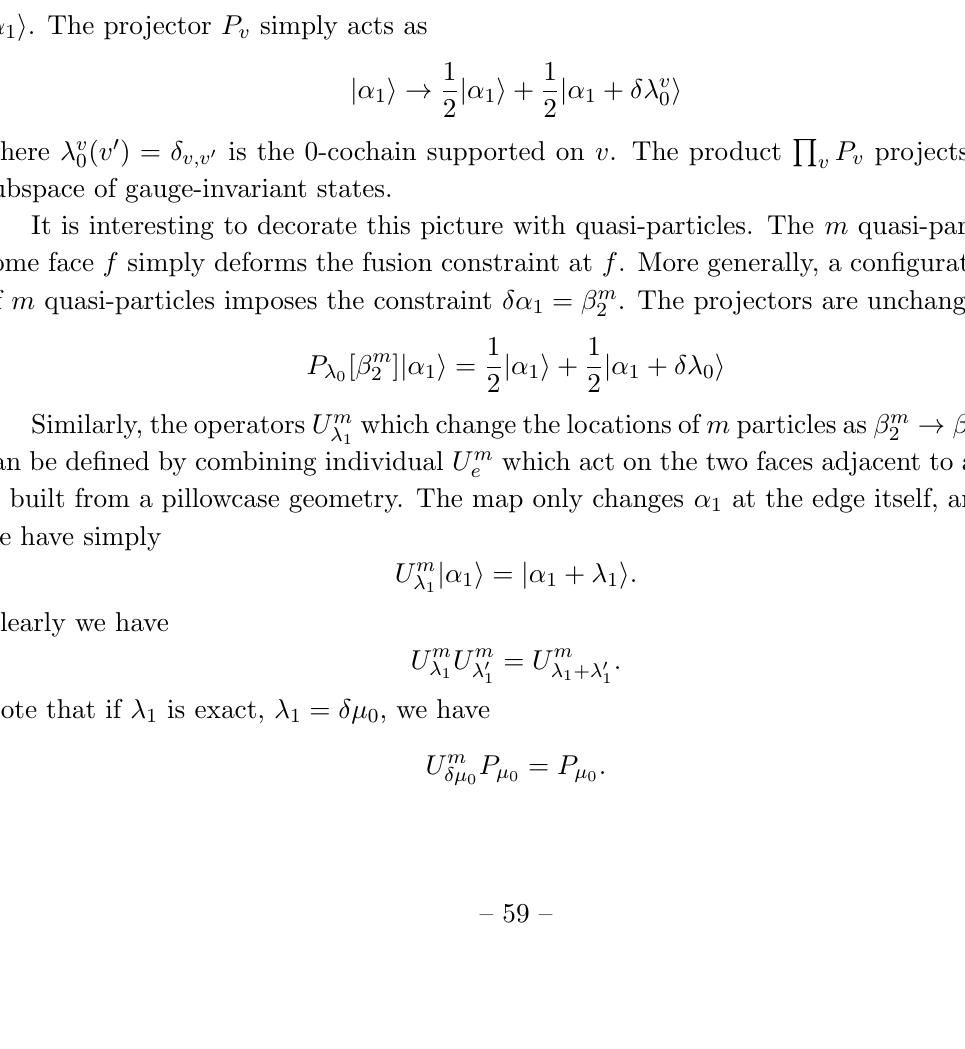
Figure 39 . Left: the projector P v in the presence of a quasi-particle at f can be computed as a state-sum model evaluation of a bi-pyramid with an extra bulk line. Right: the decorated bi- pyramid is computed in the spherical fusion category by an appropriate planar graph including the appropriate center line corresponding to the quasi-particle. The quasi-particle joins the junctions dual to the bi-pyramid faces above f . We selected a speci(cid:12)c framing for the quasi-particle (which direction it exits and enters the junctions) it and kept it